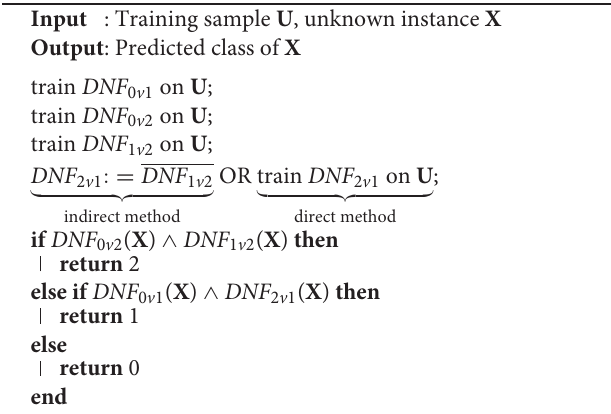
Algorithm 2 | Indirect and direct method for interpretable one-vs-one DNF classifiers.